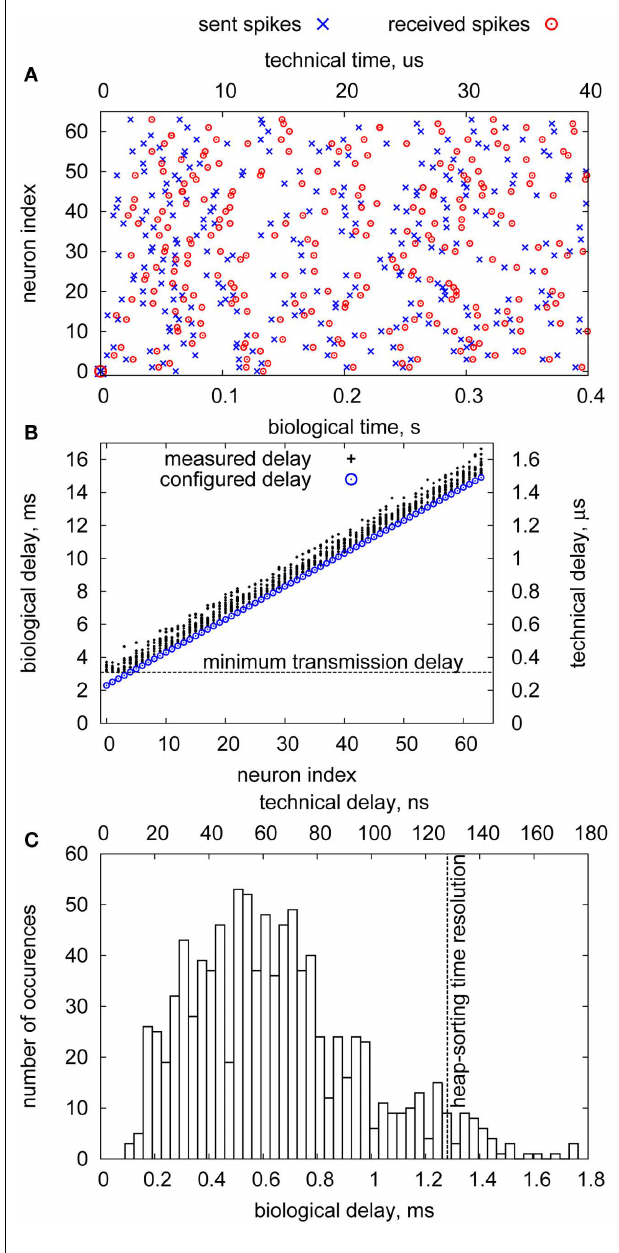
the resolution limit for biological neurons (Bohte, 2004), so that already the sorting/buffering functionality of the DNC provides biologically realistic constant-delay